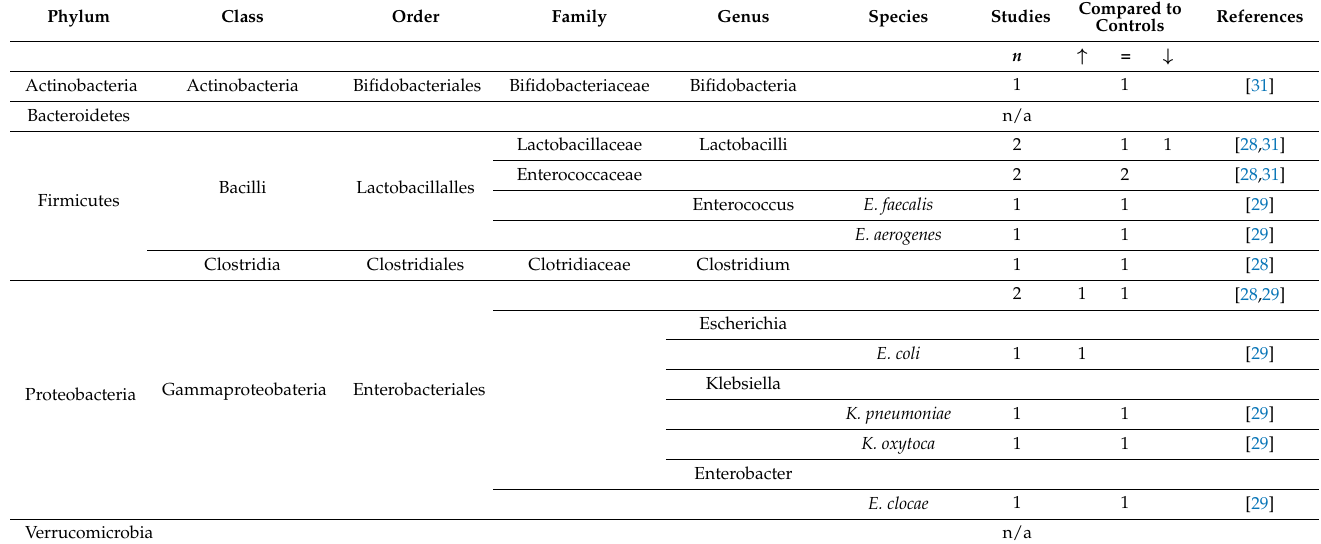
Table 3. Faecal microbiota of infants with colic compared to healthy controls. Results from research using other methods of